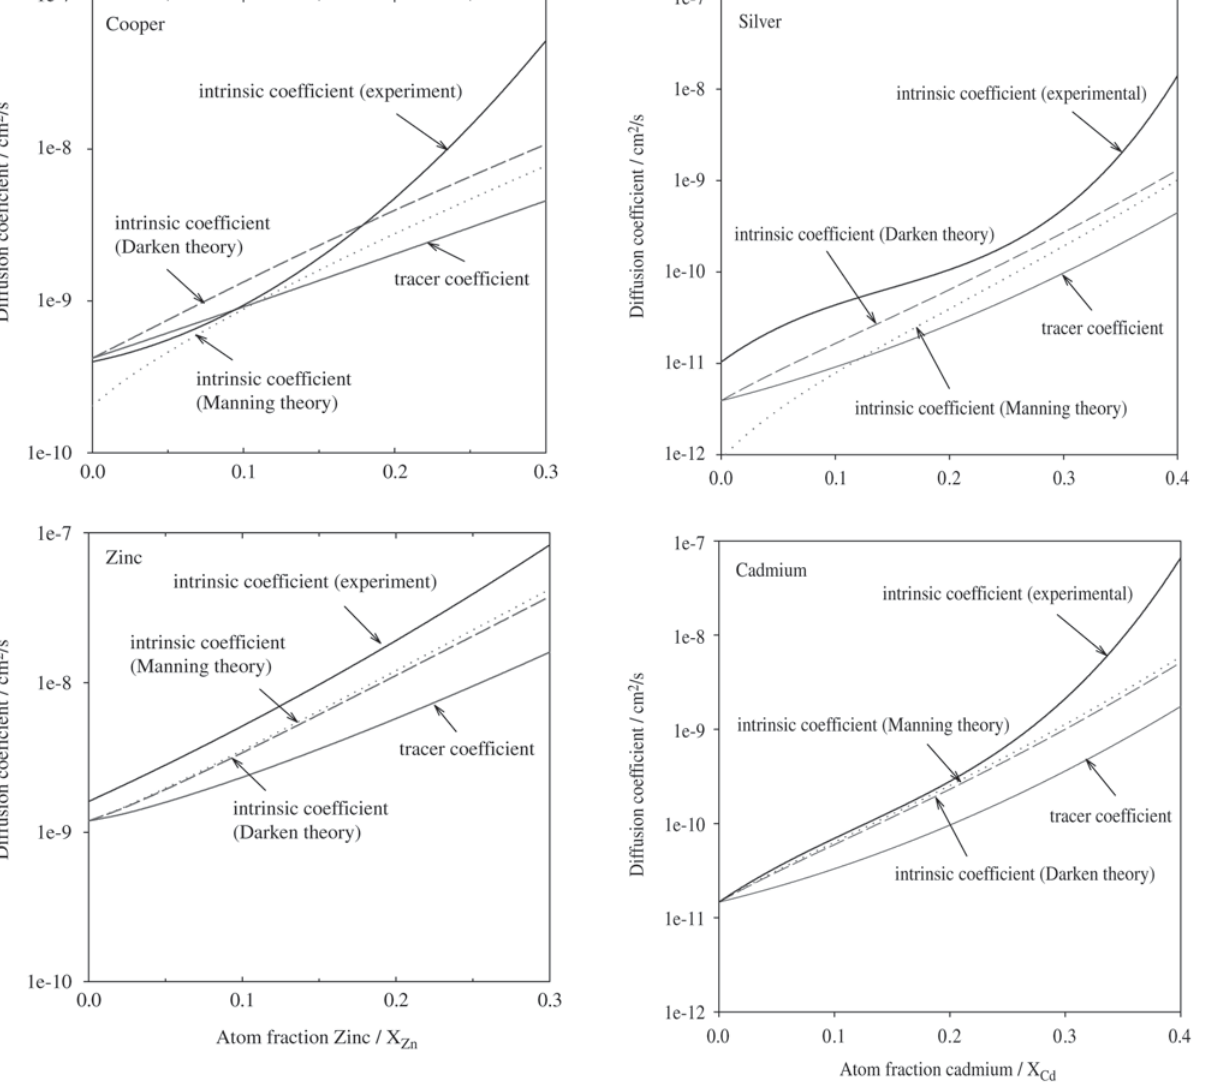
Figure 6. Darken-Manning relations in the Cu-Zn system at 915 °C. The experimental intrinsic diffusion data was obtained from Horne & Mehl 32 , the tracer data was obtained from Anusavice & DeHoff 33 and the thermodynamic data was obtained from Kowalski and Spencer 34 .